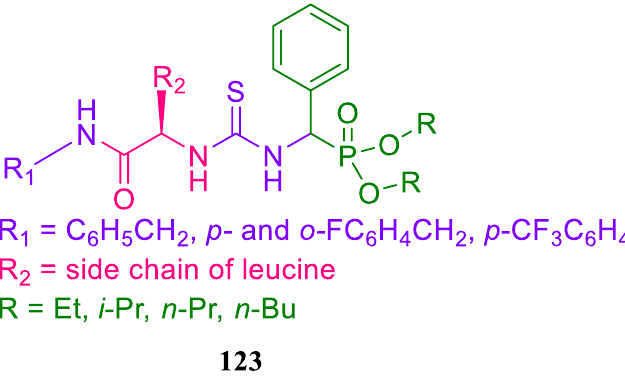
Figure 100. α -amino carboxamide derivatives.